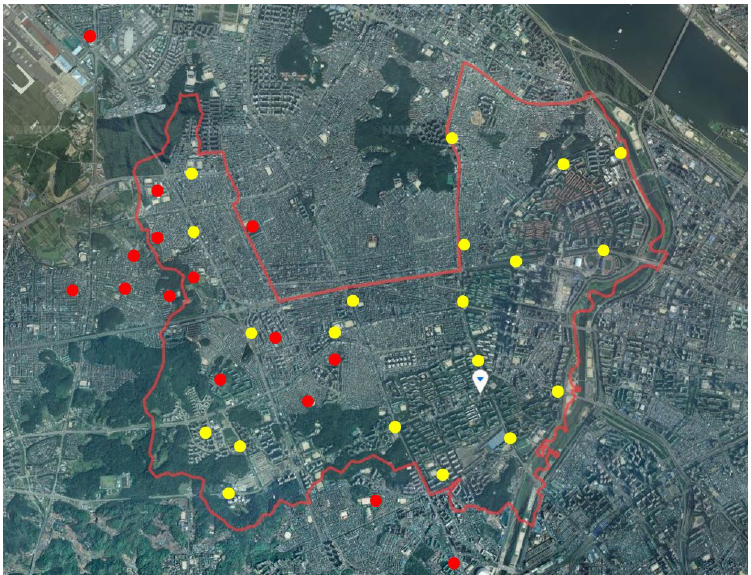
Figure 4. Noise measurement points. Aircraft (red circles); road traffic (yellow circles)